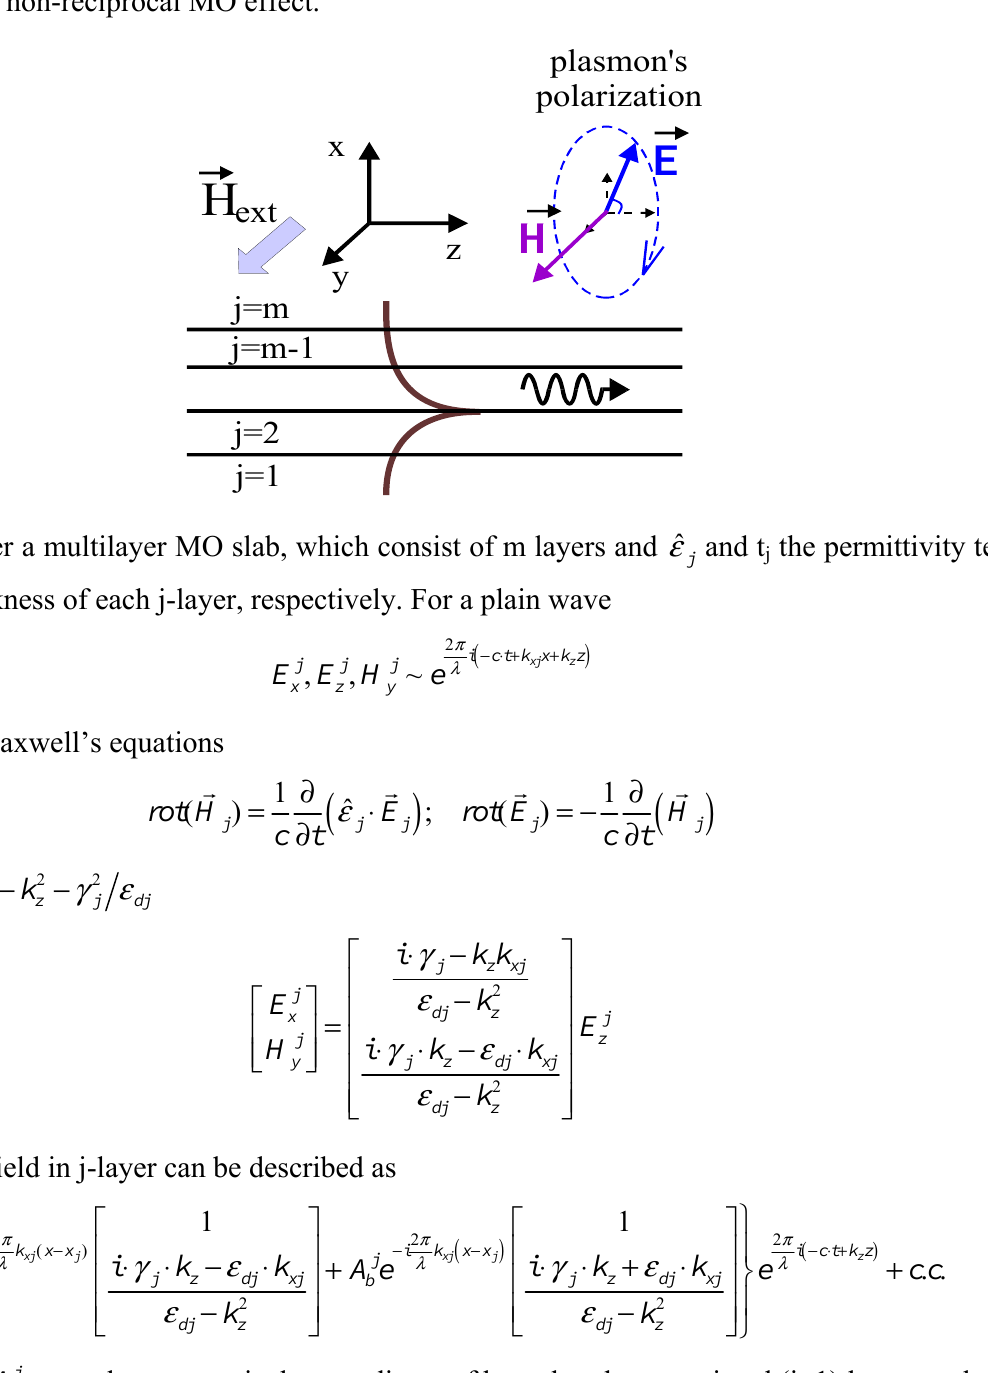
Figure 6. Schematic diagram showing the intensity of optical field for a surface plasmon propagating in plasmonic waveguide, which consists of m-layers. Plasmon’s propagation direction is along the z-axis. External magnetic field is applied along the y-axis. For plasmon’s polarization the magnetic field is directed along the y-axis and the electric field rotates in the xz-plane around the y-axis. Because of the polarization rotation around the direction of the external magnetic field, the surface plasmons experience a substantial transverse non-reciprocal MO